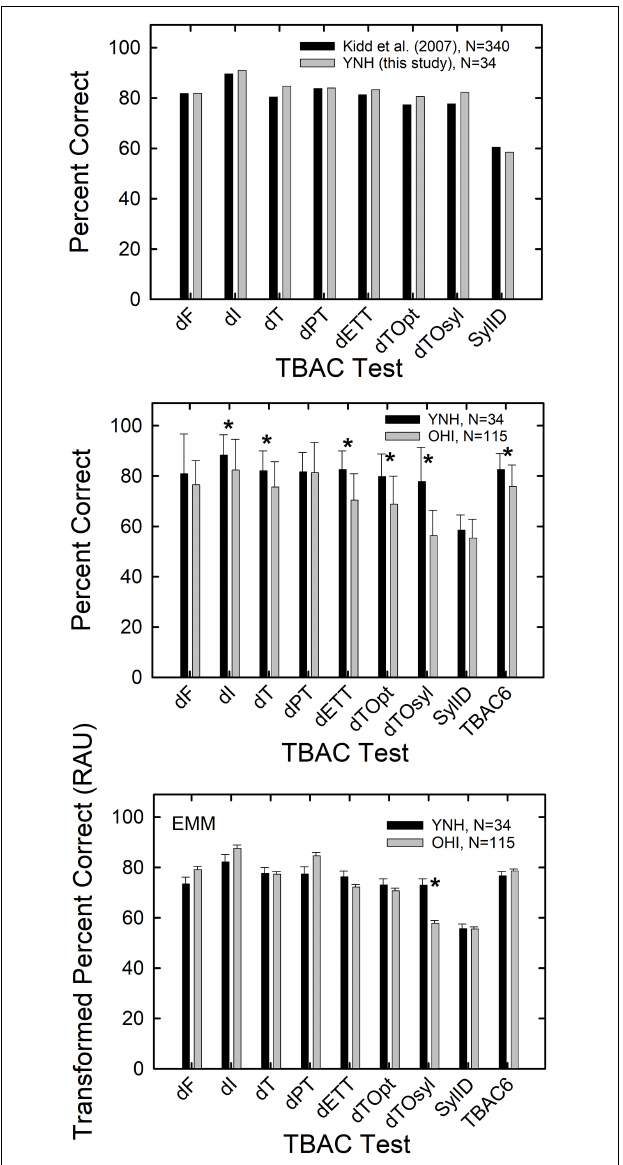
FIGURE 2 | The top panel compares the mean percent-correct performance for young normal-hearing (YNH) adults in this study ( N = 34; gray bars) to the corresponding mean normative values from Kidd et al. (2007; N = 340; black bars). The middle panel shows the means and standard deviations for the percent-correct scores on the TBAC for the 34 YNH (black bars) and 115 older hearing-impaired (OHI; gray bars) adults in this study. The bottom panel provides the estimated marginal means (EMM, controlling for PTA4 and working memory) and standard errors for the YNH (black bars) and OHI (gray bars) groups in this study. The asterisks in the lower two panels mark significant effects (adjusted p < 0.0055) of subject group.